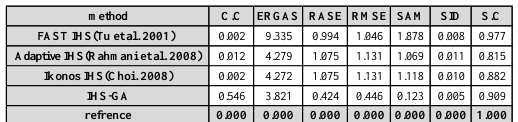
Table 1: Assessing the fusion methods (IKONOS data set)